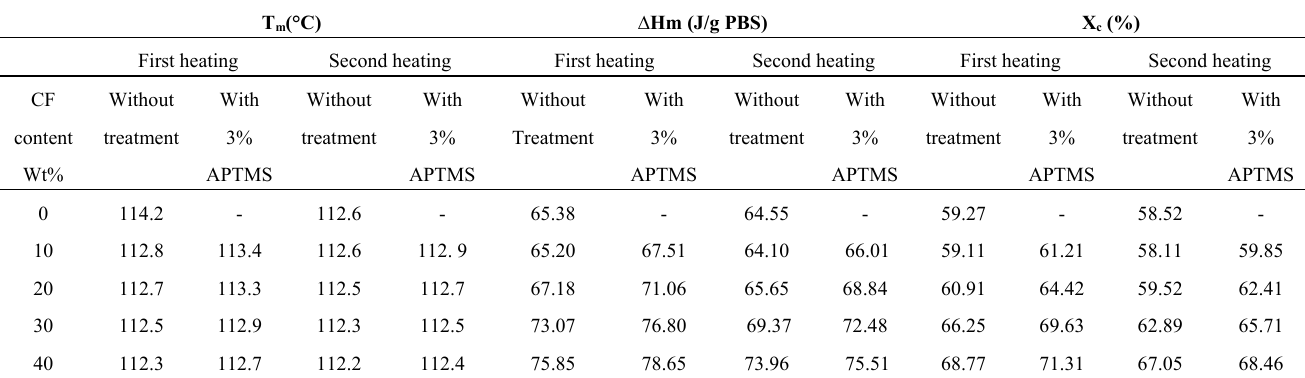
Table 1. Thermal properties of poly(butylene succinate)/cotton fiber (PBS/CF) composites with different concentrations of CF.